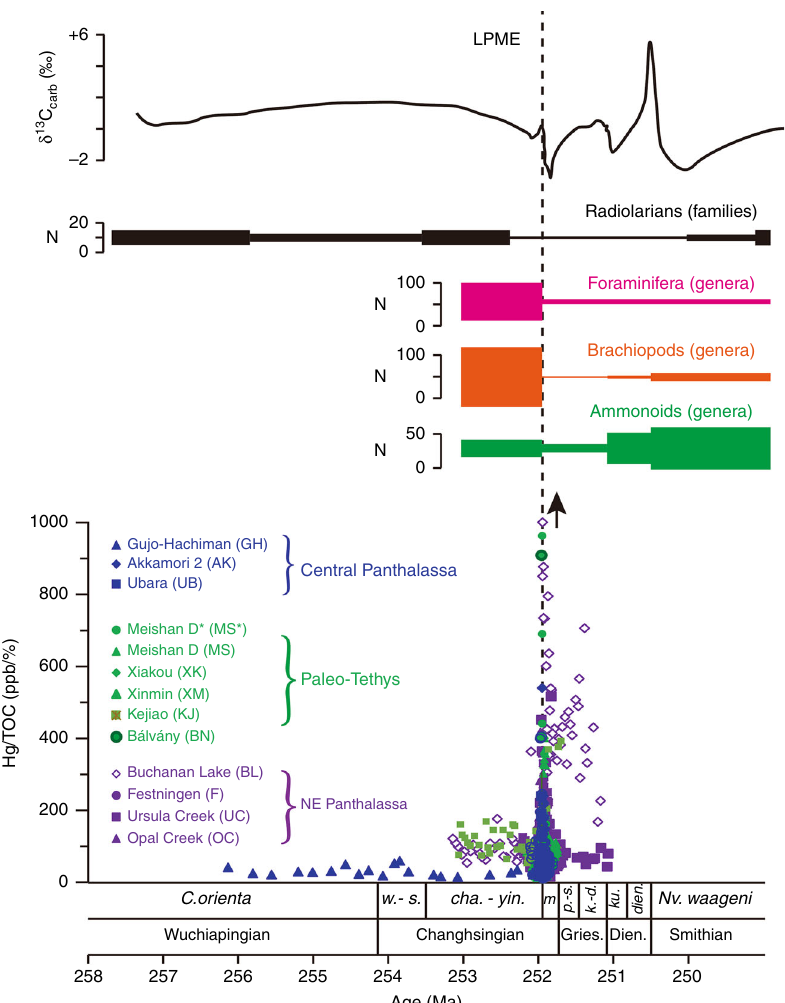
Fig. 4 Relationship of mercury records to PTB marine ecosystem perturbations. Hg/TOC values from all study sections, biodiversity variations 70,71 , and inorganic carbon isotopes 72 . C . Clarkina , cha . C. changxingensis , dien. Neospathodus dieneri , k.-d. Neoclarkina krystyni-N. discreta , ku . Sweetospathodus kummeli